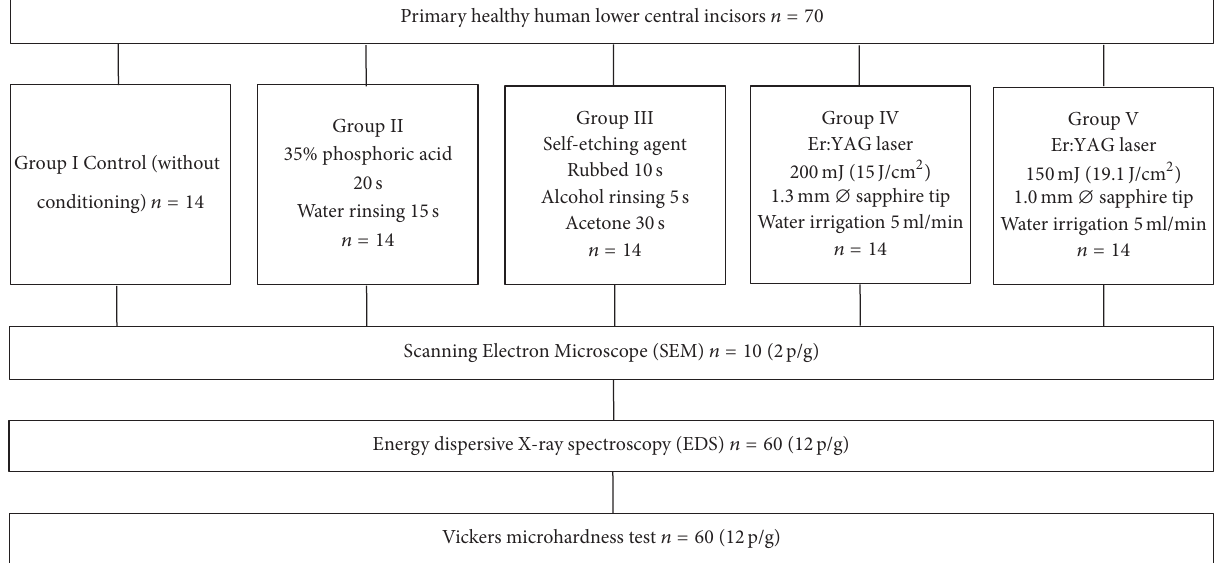
Figure 1: Diagram of the experimental